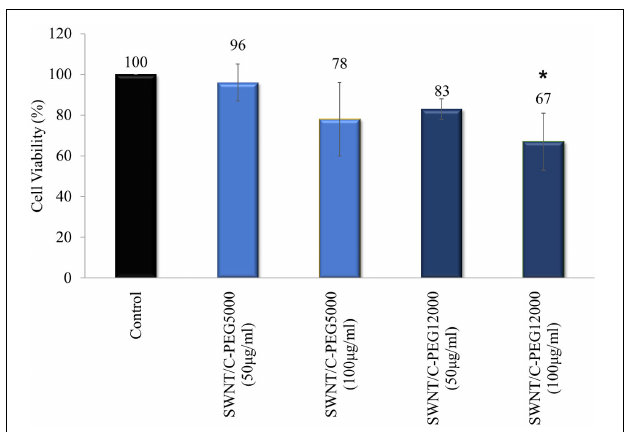
FIGURE 11 | Cell viability results for SWNT/C-PEG 5000 , and SWNT/C-PEG 12000 . Cells were treated with two concentrations of SWNT-based samples. The percentages of cell viability were normalized to control cells. These results are the mean of triplicate experiments. The results were given as mean ± SD. ∗ p < 0.05 compared to the control